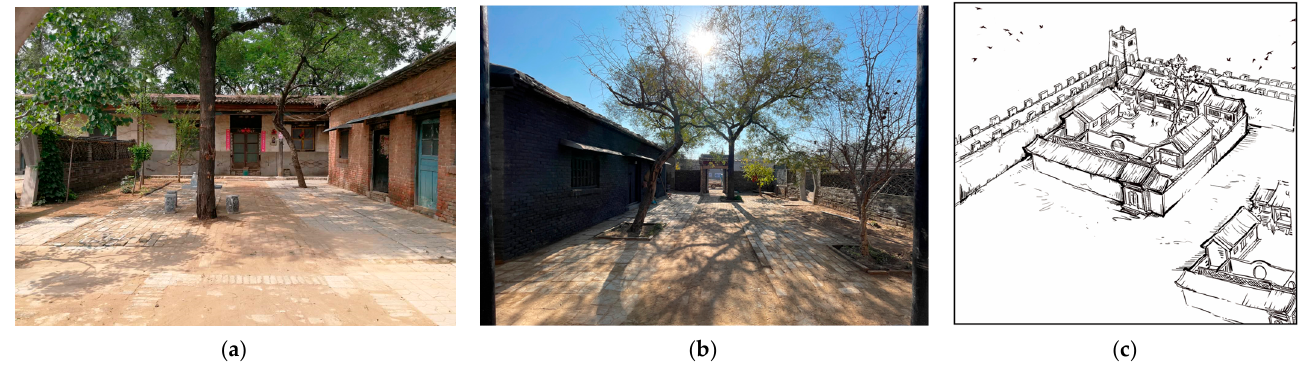
Figure 5. ( a ) Courtyard and building before rehabilitation. ( b ) Panoramic view of the courtyard . ( c ) Oral description of the original building. Photo and hand-drawn by W. Rong.